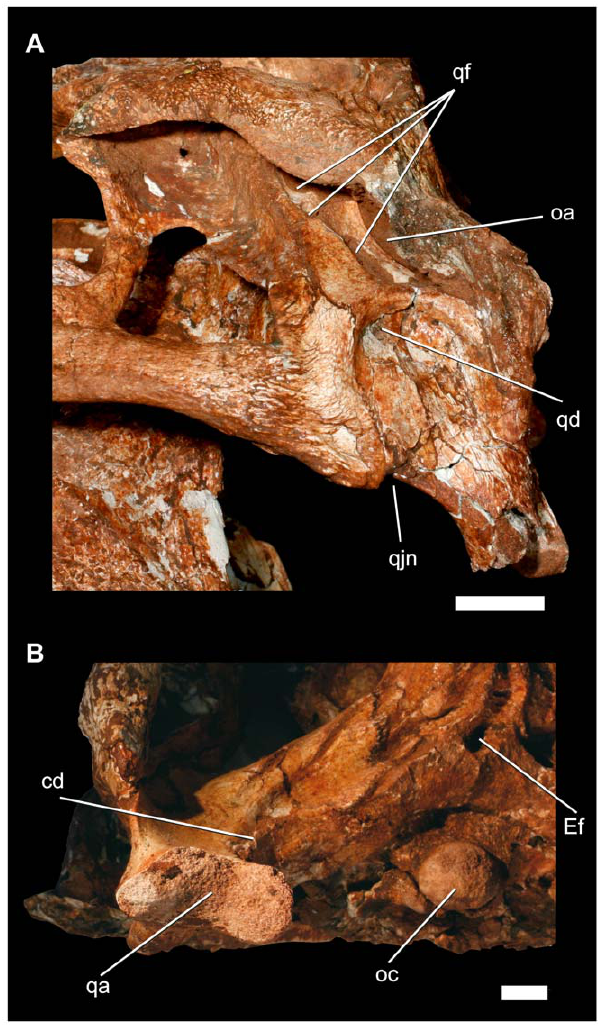
Figure 14. Details of the left posterolateral region of the cranium of Pissarrachampsasera (LPRP/USP 0019). A) lateral view; B) ventral view. Abbreviations: qa, quadrate articulation; qjn, quadra- tojugal notch. Scale bars equals 1